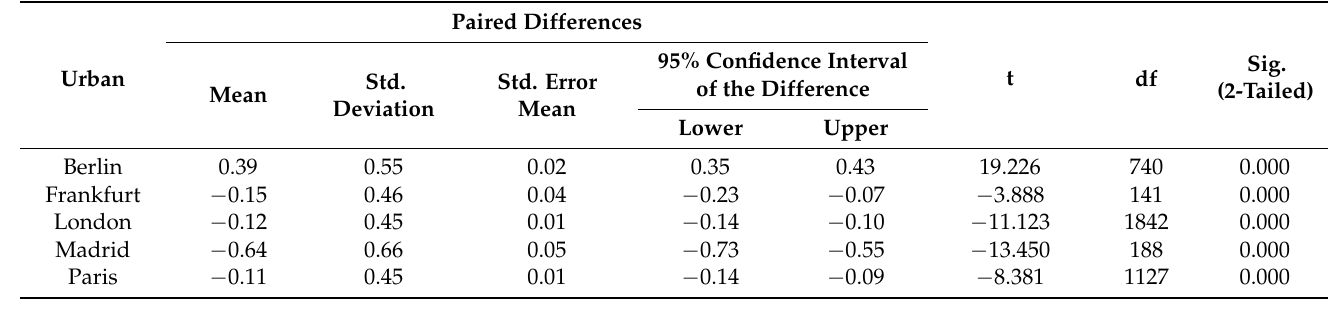
Table 2. Results of a paired-samples t -test for NUHI data belonging to the studied cities for the two time periods.